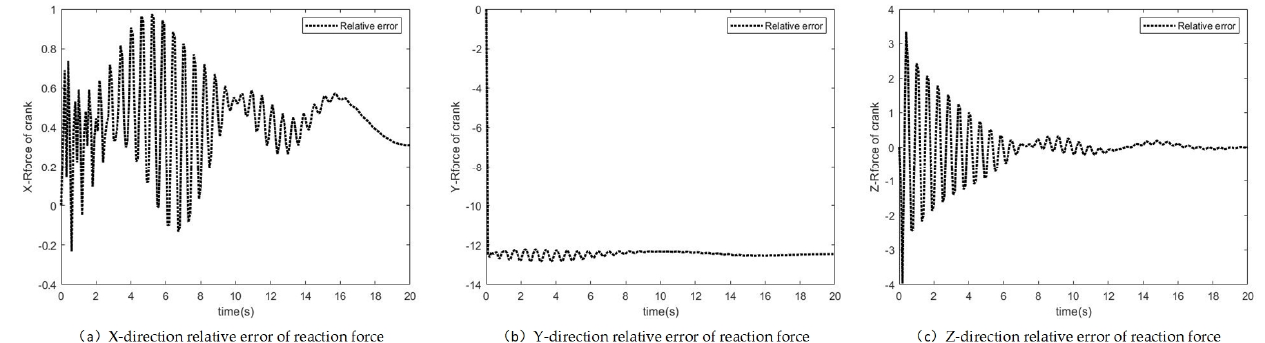
Figure 9. Relative reaction force difference of drive.